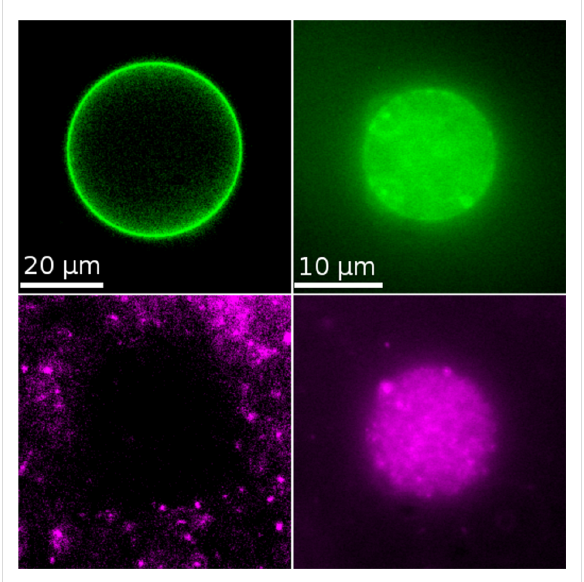
Figure 6: Size dependence for fluid phase vesicles. Left : A DOPC vesicle (green) after incubation with 123 nm particles (magenta) for 15 min. There are no signs of particle uptake. Right : The vesicle from Figure 3 after 10 min incubation with 42 nm particles. The contrast between these two systems is